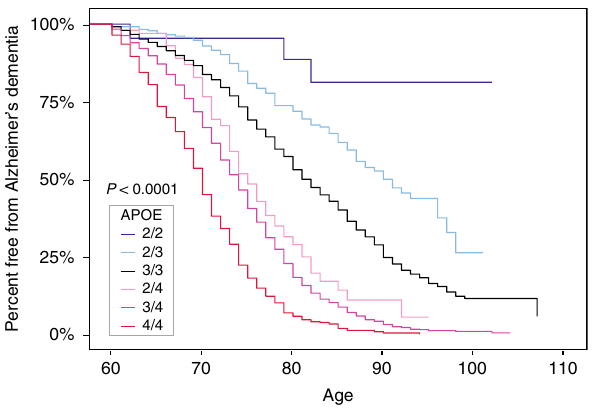
Fig. 1 Percent free from Alzheimer ’ s dementia. Kaplan – Meier curves were generated from Alzheimer ’ s dementia cases and cognitively unimpaired non-AD controls in the neuropathologically con fi rmed group. Y -axis represents the percentage of persons with each APOE genotype in the neuropathologically con fi rmed group who remained free from Alzheimer ’ s dementia. X -axis denotes age at death for controls and age at onset of cases, while replacing with age at death when age at onset was